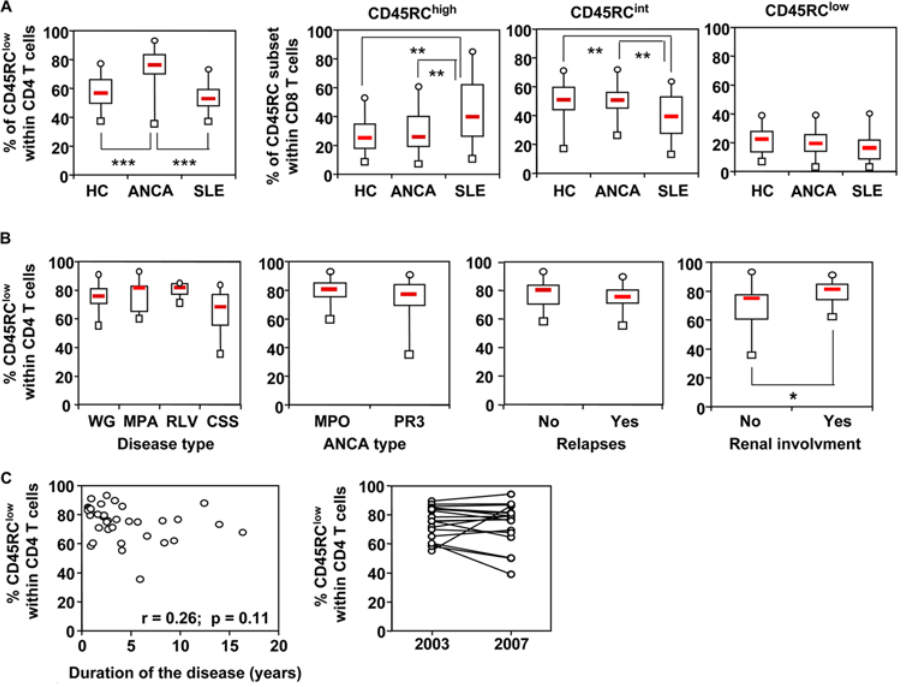
Figure 3. CD45RC T cell subsets distribution in healthy individuals and ANCA patients. Peripheral blood leukocytes from 39 healthy individuals (HC), 38 patients with ANCA-associated vasculitis (AAV), and 20 patients with systemic lupus erythematosus (SLE), were stained with mAbs against CD3, CD4, CD8, CD45RC. ( A ) The proportion of CD45RC low CD4 T cells (left panel) and the proportion of CD45RC high -CD45RC int -CD45RC low CD8 T cells (right three panels) are presented as box plot diagrams for each study population. The p-values were calculated using the Wilcoxon matched-pairs test; p , 0.05; **, p , 0.02; ***, p , 0.002. ( B ) The proportion of CD45RC low CD4 T cells are presented according to disease subtype (WG, Wegener’s granulomatosis; MPA, microscopic polyangiitis; CSS, Churg-Strauss Syndrome; RLV, renal limited vasculitis), type of ANCA specificity (MPO, myeloperoxidase; PR3, proteinase 3), renal involvement (no: no kidney disease; yes: kidney disease), and relapses (no: no relapse; yes: relapses). Data are presented as box plot diagrams for each study population. The p-values were calculated using Mann Witney U test; *p , 0.05. The proportion of CD45RC low CD4 T cells are presented according to duration of disease ( C , left panel). The proportion of CD45RC low CD4 T cells of 18 AAV patients (13 WG, 3 MPA, and 2 RLV patients) at 4 years interval ( C , right